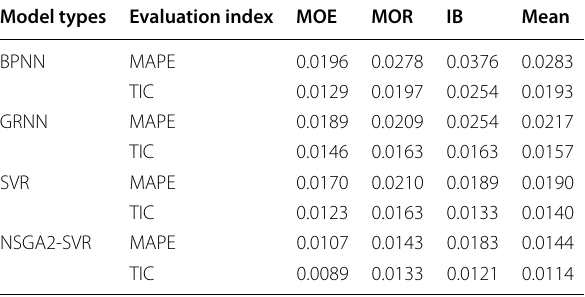
Table 3 Evaluation results of the BP model, GRNN model, SVR model, and NSGA2-SVR